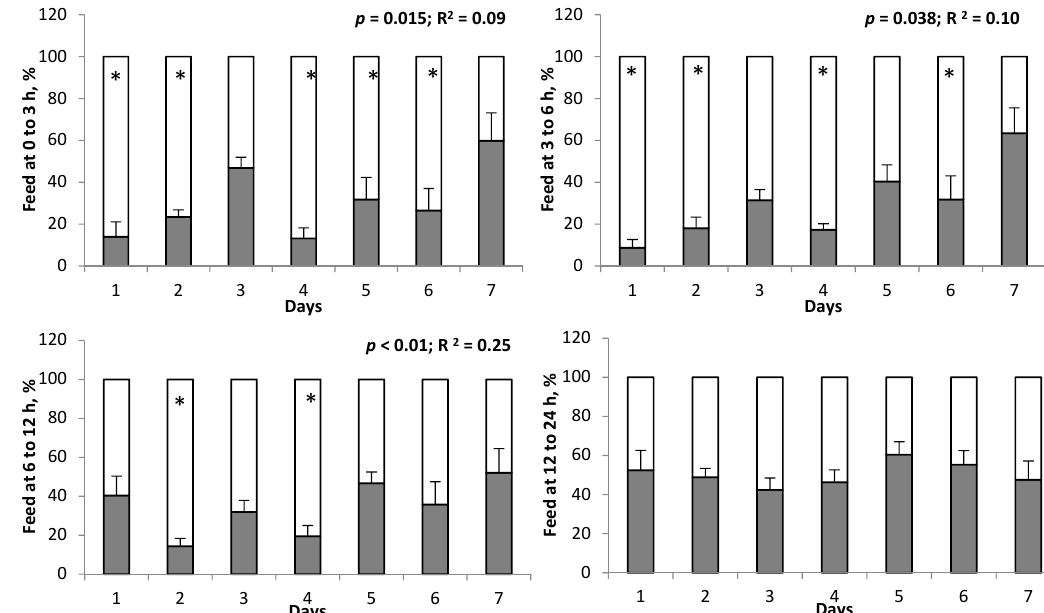
Figure 2. Proportions of a high forage diet without (white portion of the bars) or with 3-NOP (black portion of the bars) consumed by beef steers at 0 to 3, 3 to 6, 6 to 12, and 12 to 24 h during the preference period ( n = 9; Exp. 1). Day 1 to 7 corresponds to the 7 d preference period. The symbol * indicates that the proportion of CON diet consumed minus proportion of 3-NOP diet consumed within day is not equal to 0 ( p < 0.05). If P and R 2 values are shown, a significant linear change in intake of 3-NOP diet, as a percentage of total dry matter intake, occurred over the 7 day preference period.